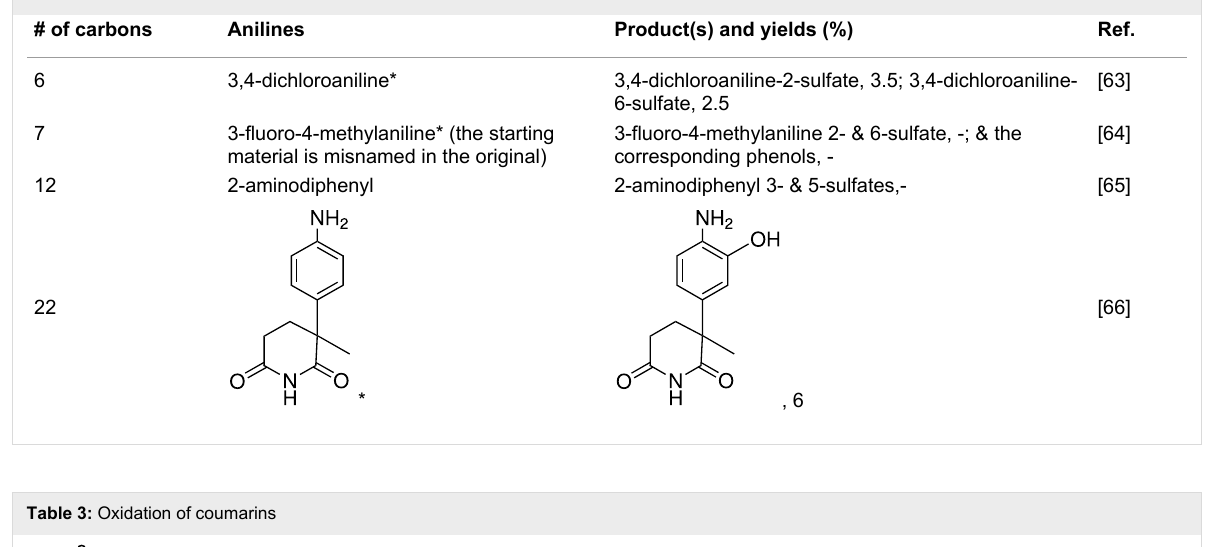
# of carbons Coumarin Product(s) and yields (%) Ref.